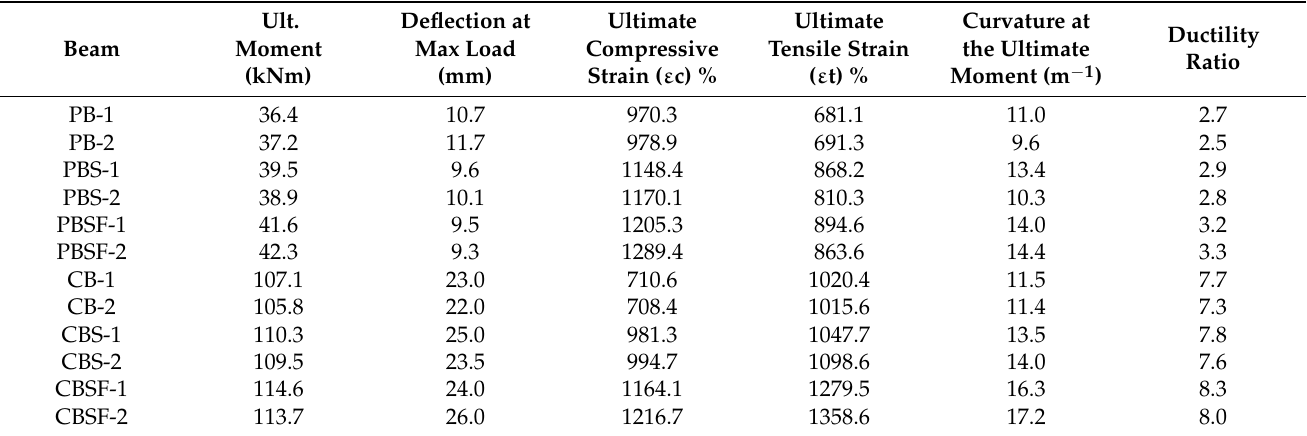
Table 4. Performance assessment of the beams investigated in this